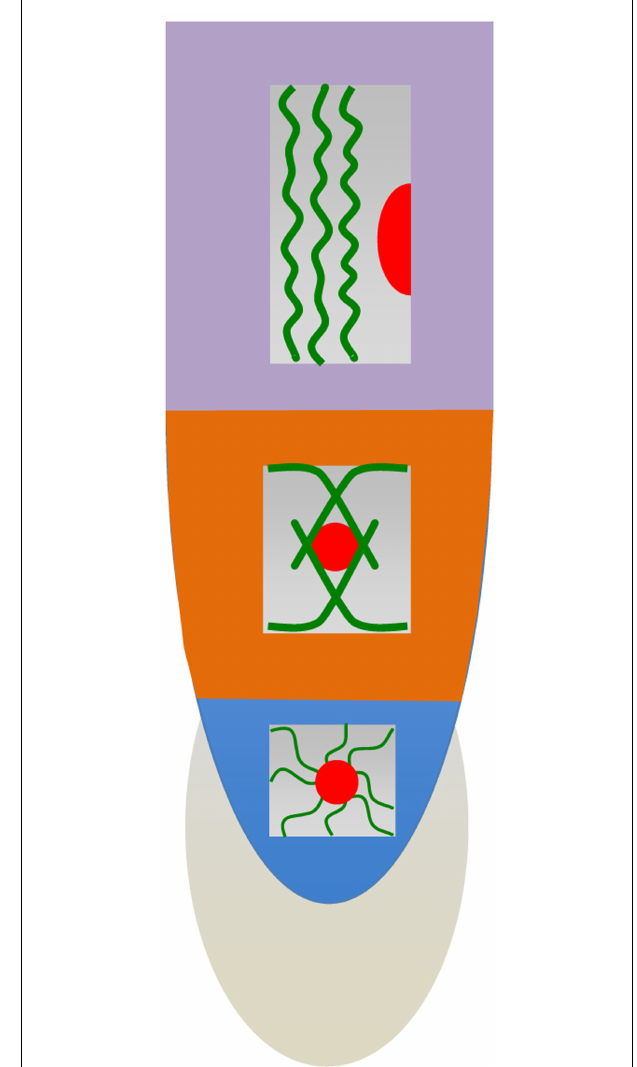
FIGURE 3 | Schematic views of cellular architecture in meristem, transition zone and elongation region. Cells in the meristem are characterized with centrally positioned nuclei suspended in networks of F-actin and radial arrays of perinuclear microtubules (Baluška etal., 1992, 1997, 2000c;Voigt etal., 2005b). In the transition zone, nuclei still keep their central position, but fine F-actin networks are replaced by bundles of F-actin organized via the nuclear surface and the end-poles enriched with myosinVIII (Baluška etal., 1997, 2000c; Reichelt etal., 1999). In the elongation region, cells start to elongate very rapidly and develop their central vacuole which is pushing their nuclei toward the side walls. F-actin bundles obtain longitudinal and wrinkled/loosened appearances (Baluška etal., 1997, 2000c;Voigt etal., 2005b).